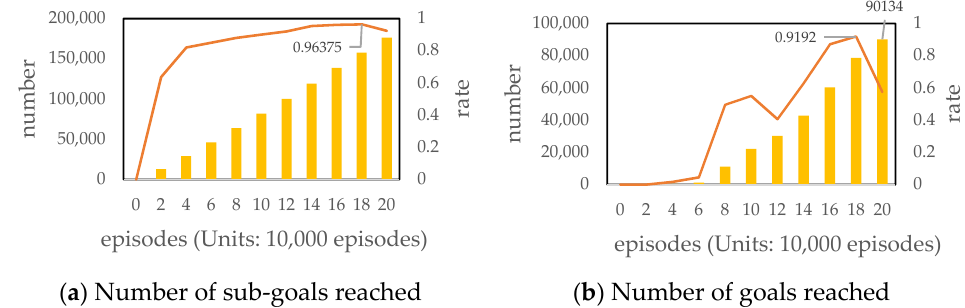
Figure 7. Cumulative number of goal and sub-goals reached depending on the number of learning using the proposed approach: ( a ) number of sub-goals reached, and ( b ) number of goals reached. The x -axis is number of episodes (units: 10,000 episodes), the left y -axis is number of sub-goals/goals reached, and the right y -axis is reach rate.